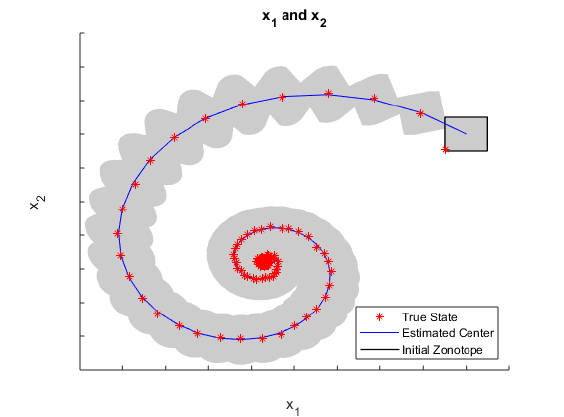
Figure 12. Qualitative evolution of the state estimation under the Zonotopic and Gaussian Kalman Filter (ZGKF) for a hybrid linear time-invariant